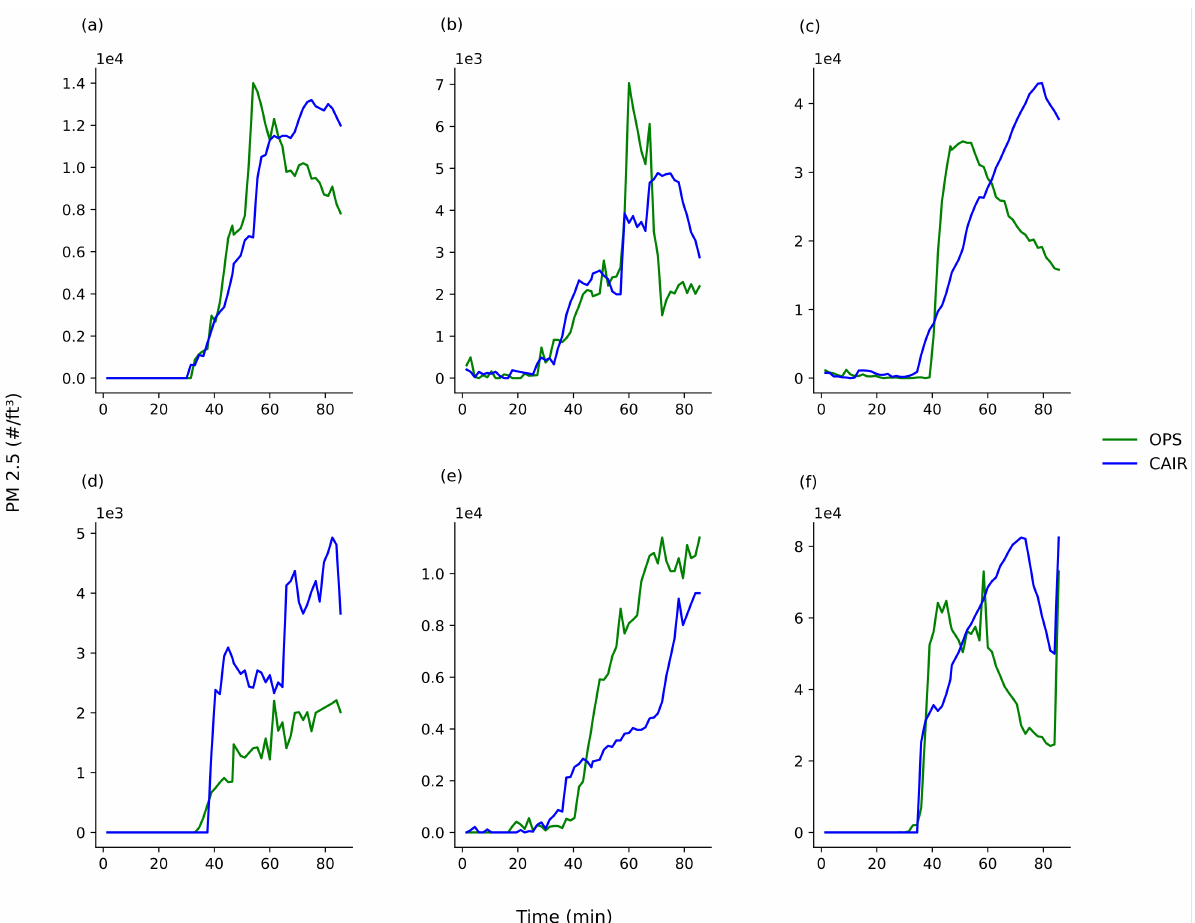
Figure 7. Comparison of PM 2.5 emission profiles taken with the OPS and Cair sensors during the printing of the test cube using ( a ) ABSB5w, ( b ) ABSB5y, ( c ) ABSB5b, ( d ) PLAB8w, ( e ) PLAB8y, and ( f ) PLAB8b. Print conditions as stated in Figure